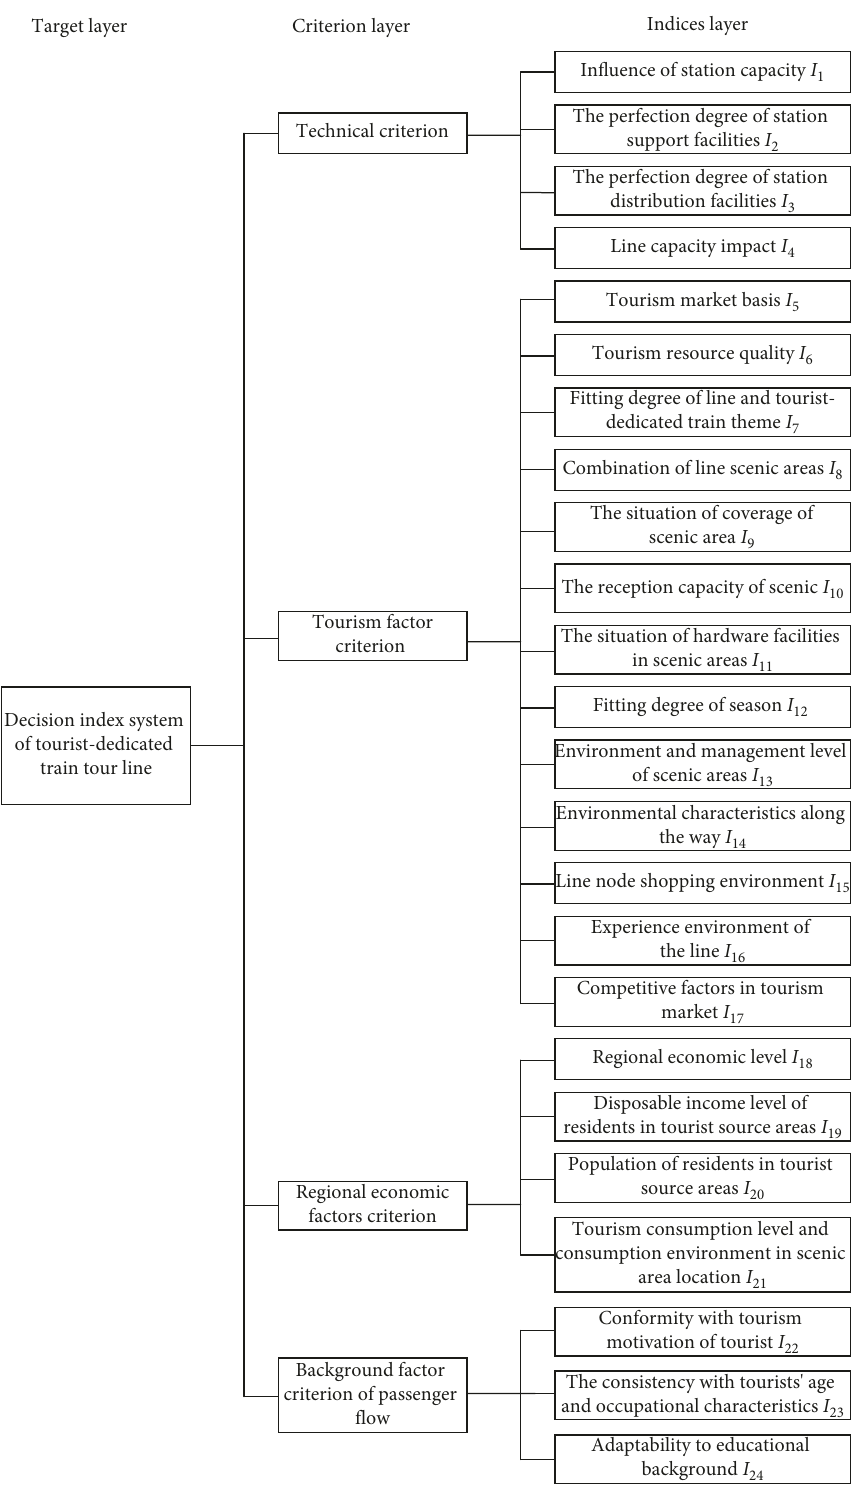
Figure 2: The decision-making index system of tourist-dedicated train